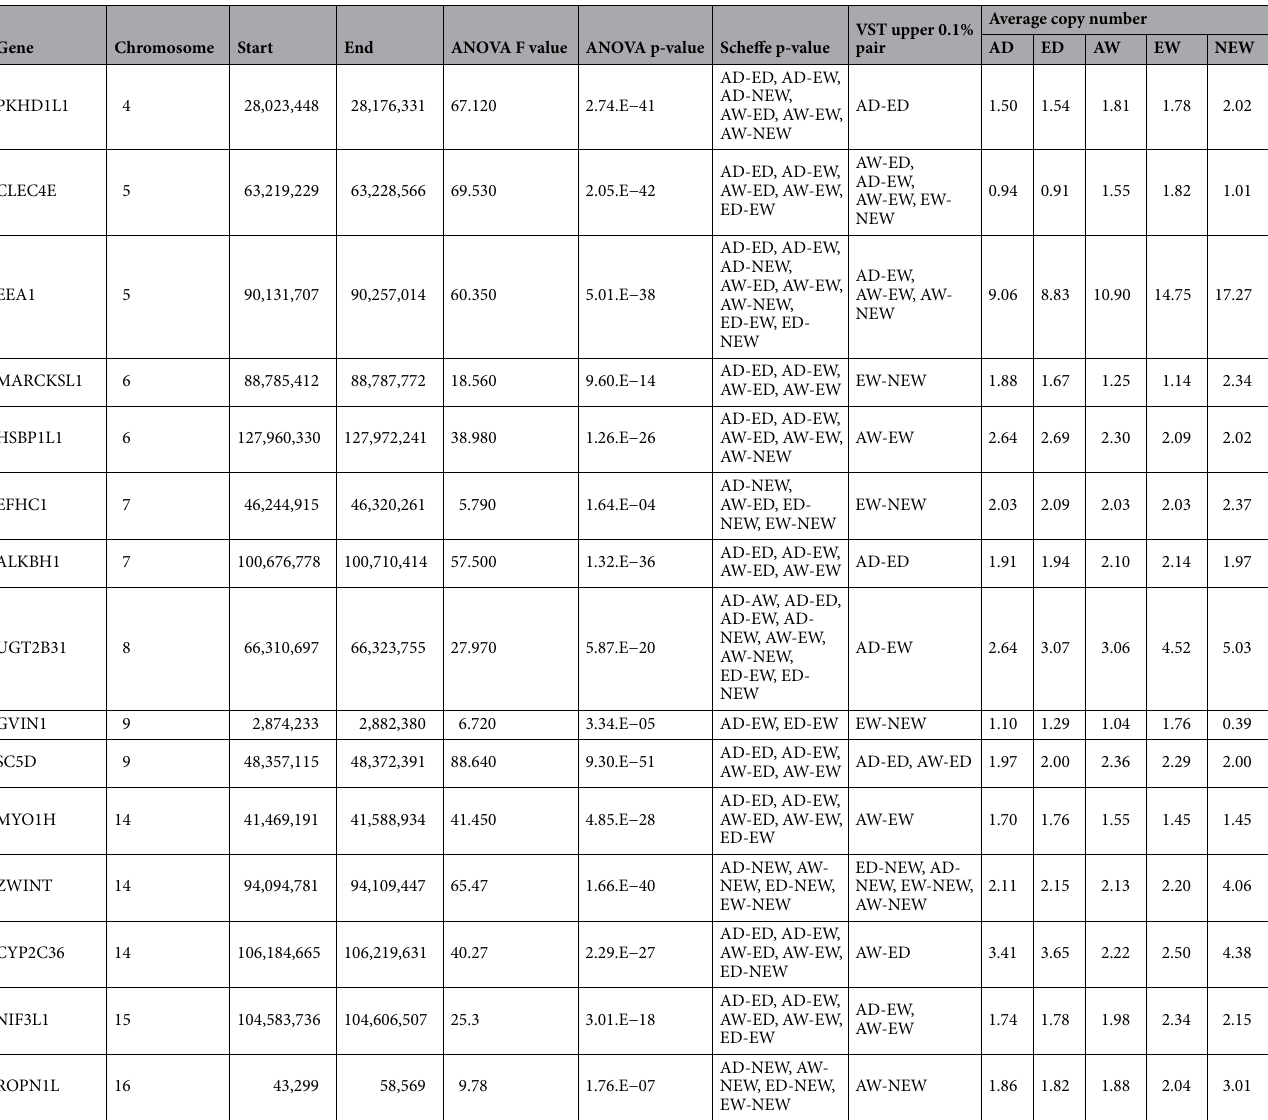
Table 1. Genes with differentiated copy number between populations.